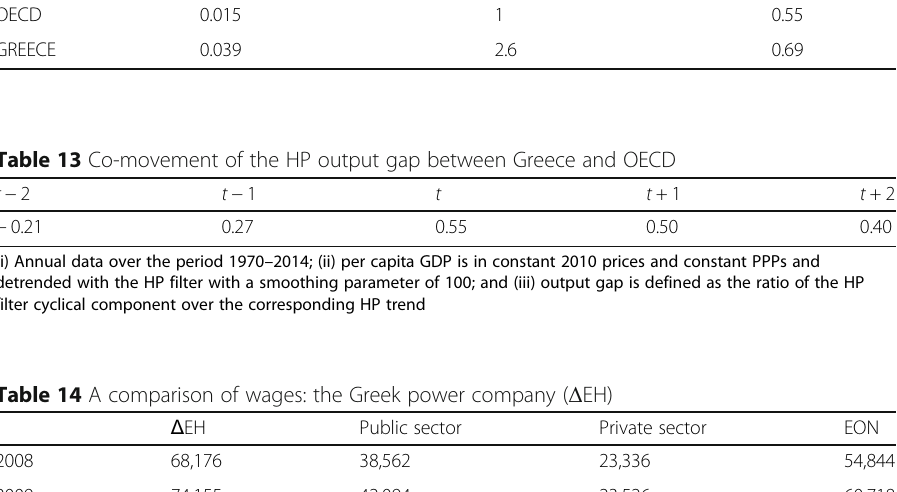
Table 12 Second moment properties of the HP output gap Standard deviation Relative volatility Autocorrelation OECD 0.015 1 0.55 GREECE 0.039 2.6 0.69